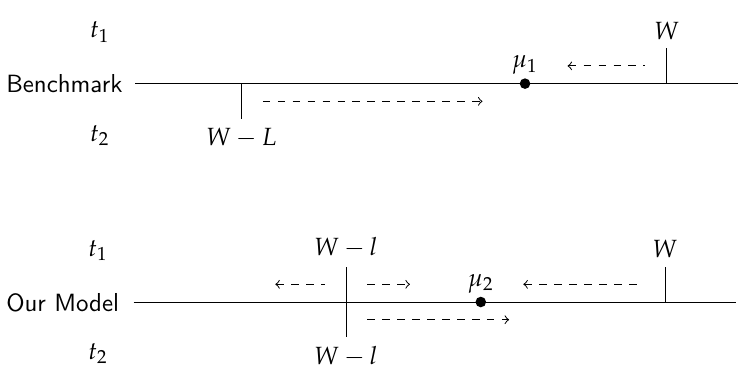
Figure 4. Wealth prospects with insurance